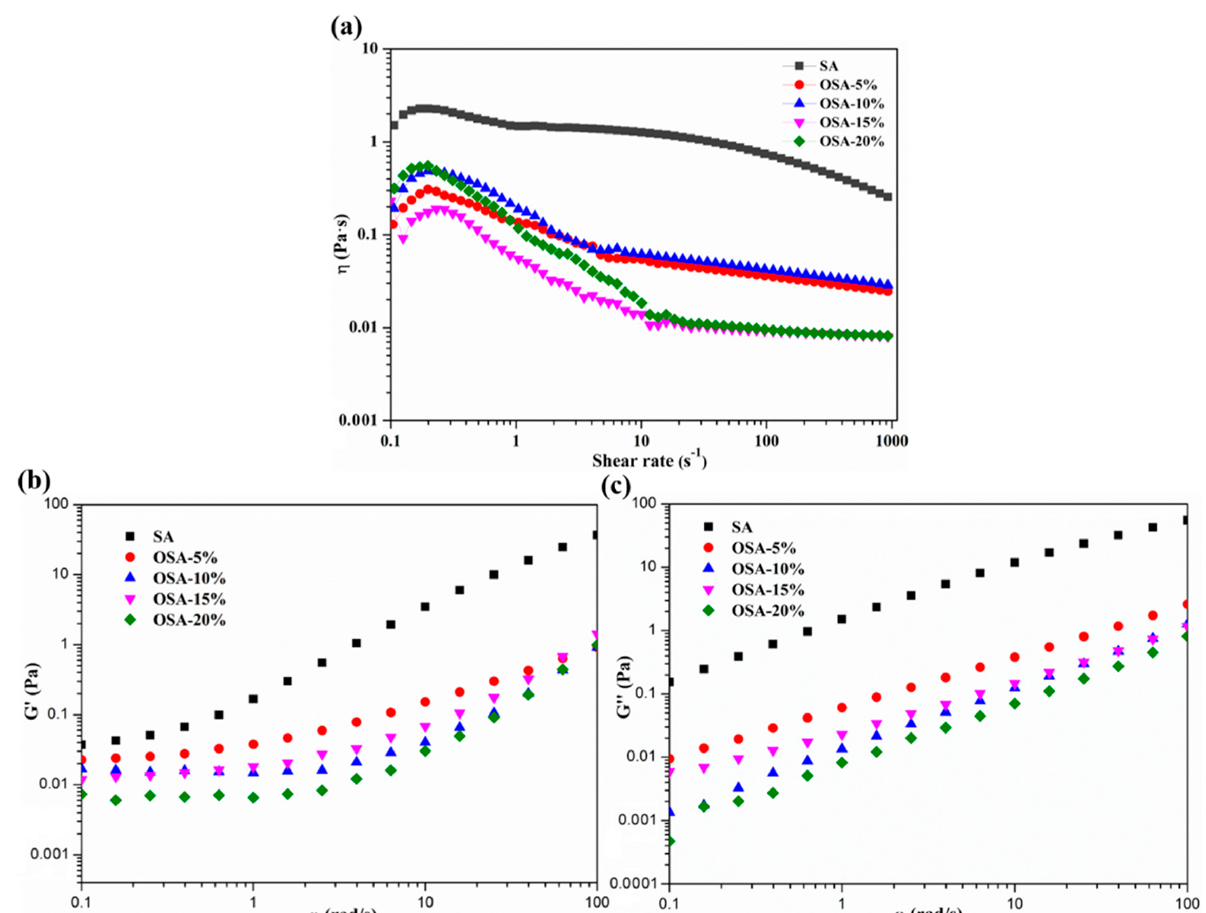
Figure 9. ( a ) Viscosity of SA hydrogel and OSA hydrogel with various ODs as a function of shear rate at 25 °C; ( b ) viscosity of SA hydrogel and OSA hydrogel with various ODs as a function of shear rate; ( c ) storage (G’) and loss (G’’) moduli of SA hydrogel and OSA hydrogel with various ODs as functions of angular frequency ( ω ).